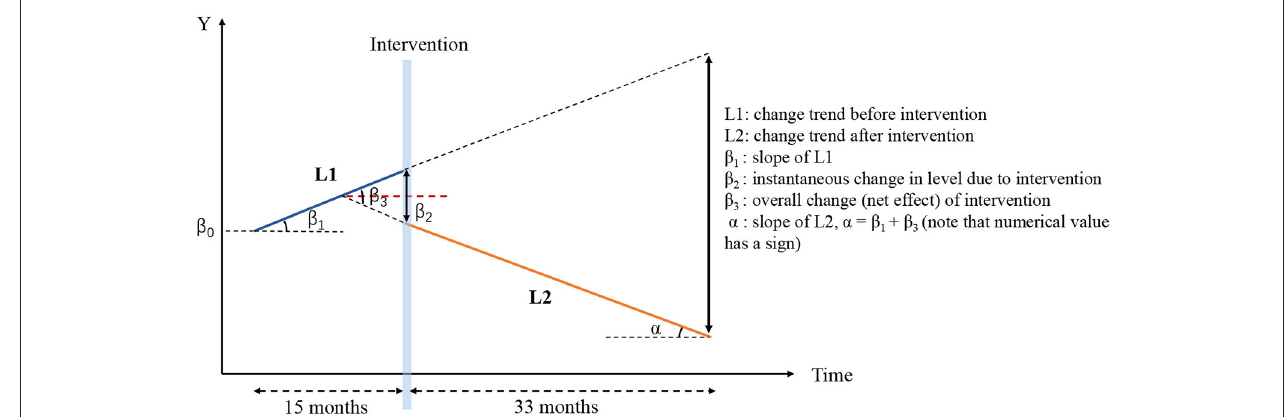
FIGURE 1 | Graphical illustration of interrupted time series analysis model in this study.